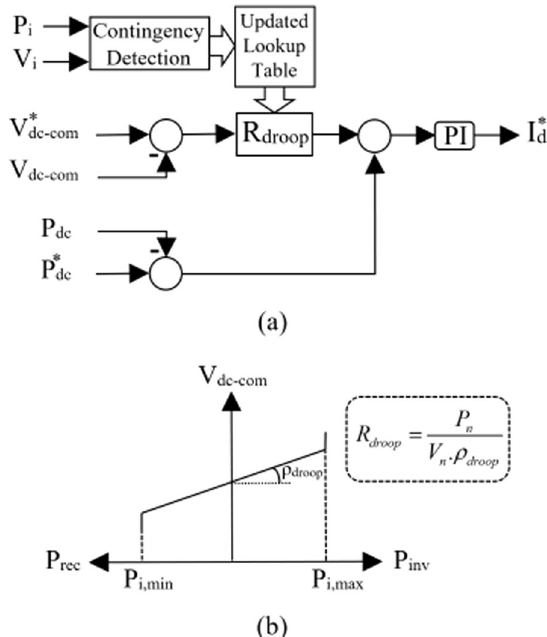
Fig. 2 a Block diagram of the proposed droop control; b the P–V characteristic